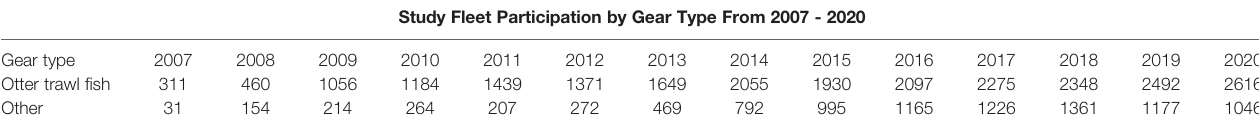
TABLE 2 | Study fl eet participation by gear